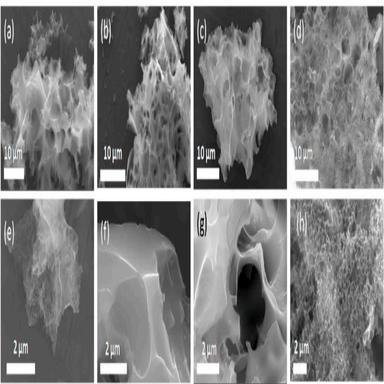
SEM images of (a) AC-1, (b) AC-2, (c) AC-3 and (d) AC-4 atrelatively lower magnification; (e), (f), (g) and (h) with higher magnification, respectively. All show porous, sheet-like morphology.